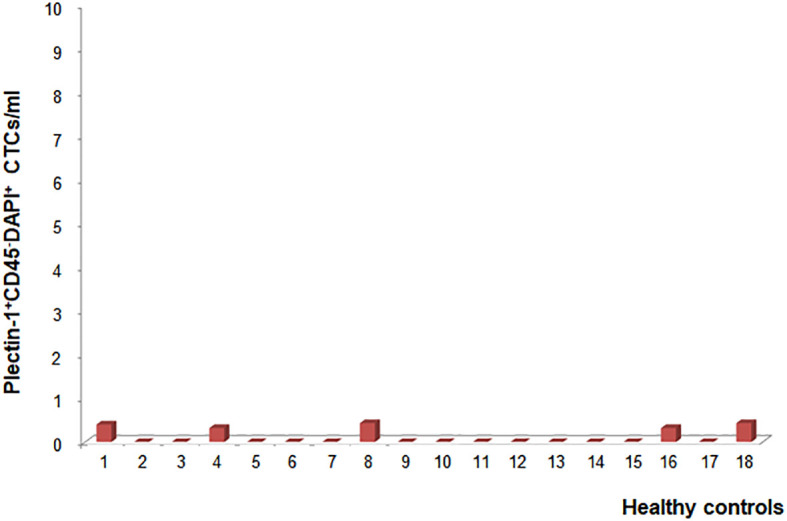
Optimization and validation of Plectin-1 in healthy controls. To validate the specificity of Plectin-1 antigen in detecting circulating tumor cells (CTCs), the number of CTCs was counted in peripheral blood samples of eighteen healthy volunteers after immunostaining with anti-Plectin-1 and anti-CD45 antibody. Plectin-1+CD45-DAPI+ CTC counts per 1 ml blood were calculated individually.